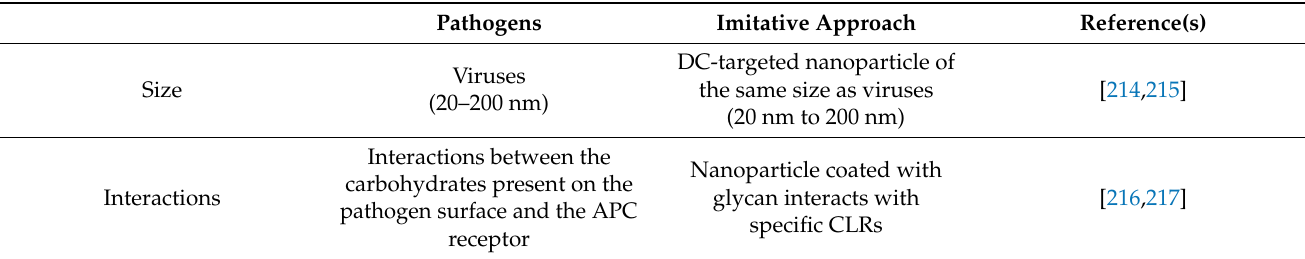
Table 3. Immune response due to pathogens and imitative